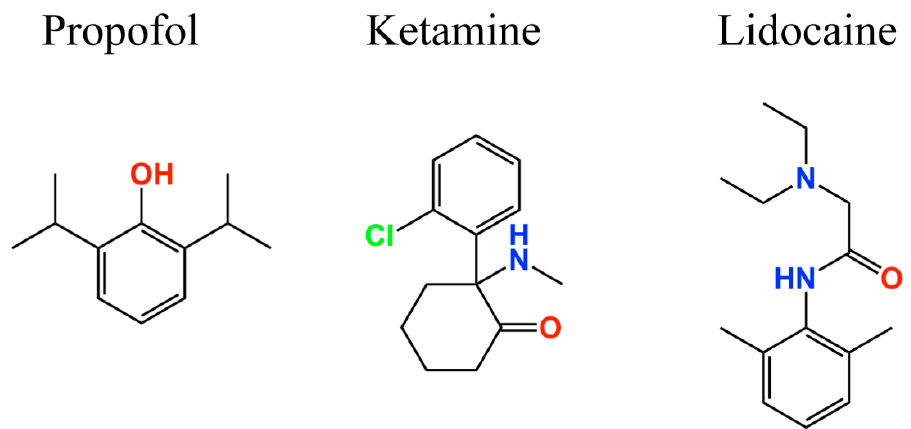
Figure 4. Two-dimensional structures of anesthetic drugs targeting HCN channels.